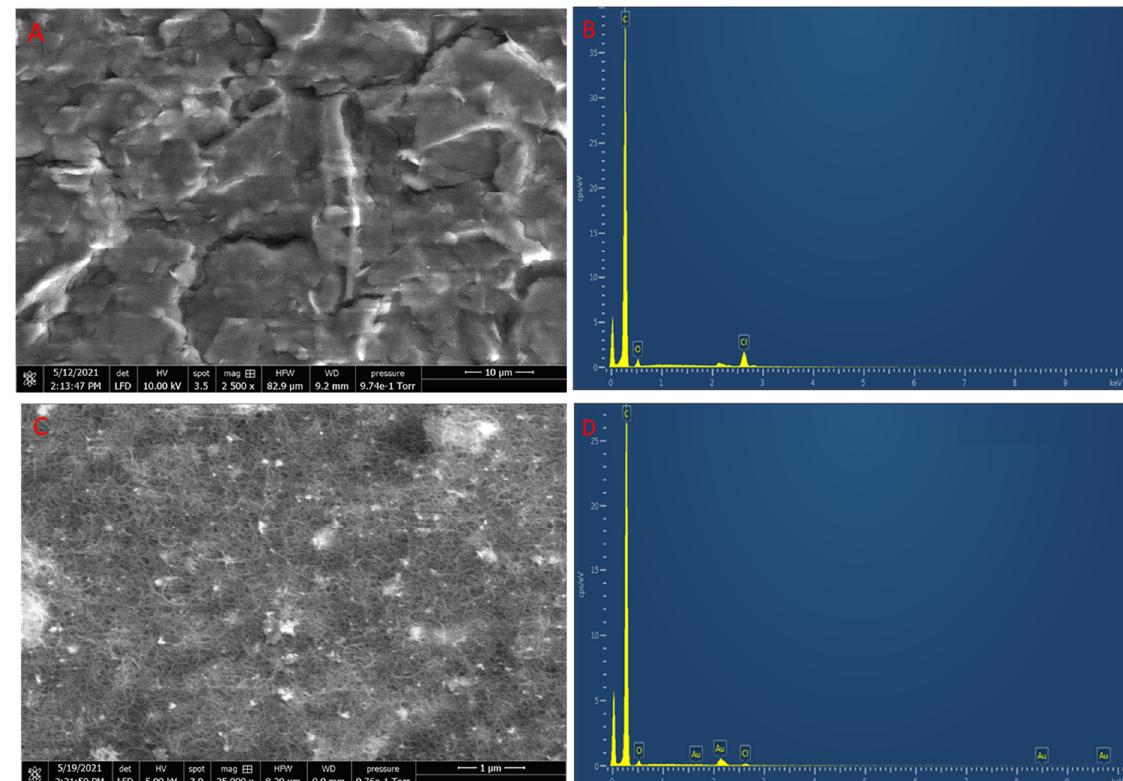
Figure 3. ( A ) SEM image of bare SPE. ( B ) EDS image of bare SPE showing elemental C, O, and Cl. ( C ) SEM image of rGO-AuNP/CNT/SPE at 25,000× magnification, with no observable rGO. ( D ) EDS image of rGO-AuNPs/CNT/SPE showing elemental C, O, Cl, and Au. To confirm the assembly of AuNPs and the surface composition of rGO-AuNPs/CNT,